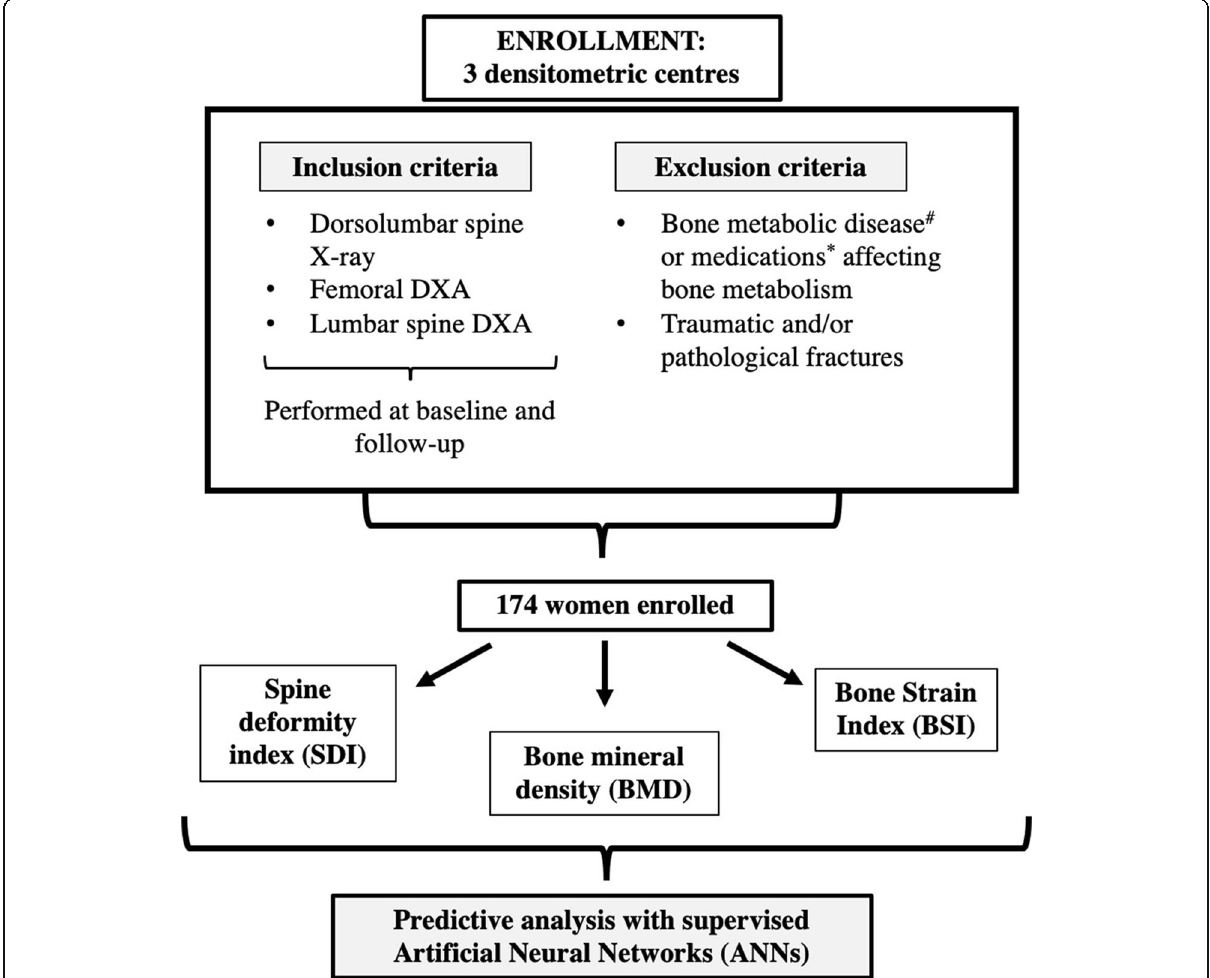
Fig. 1 Overview of the study. After applying the inclusion/exclusion criteria, we enrolled a final number of 174